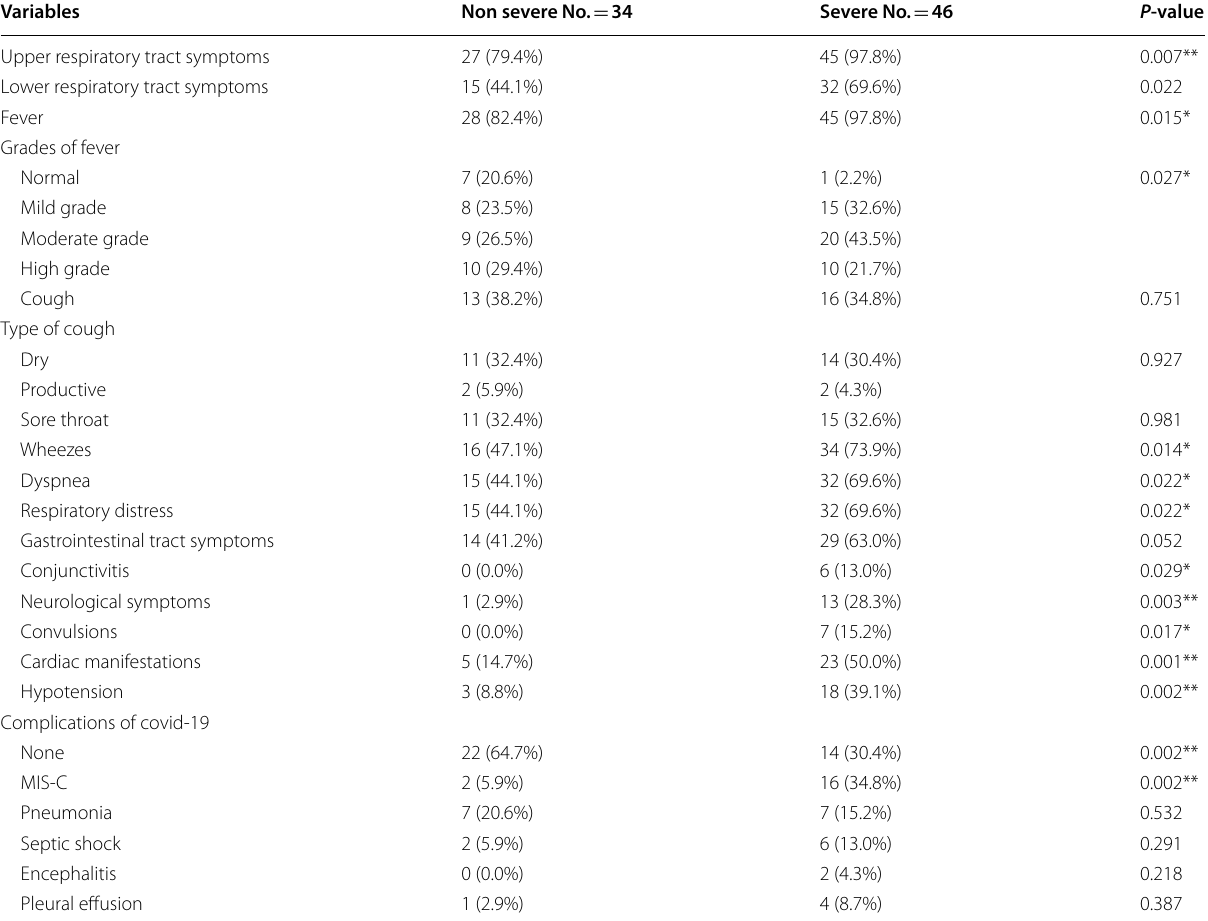
MIS-C Multisystem inflammatory syndrome in